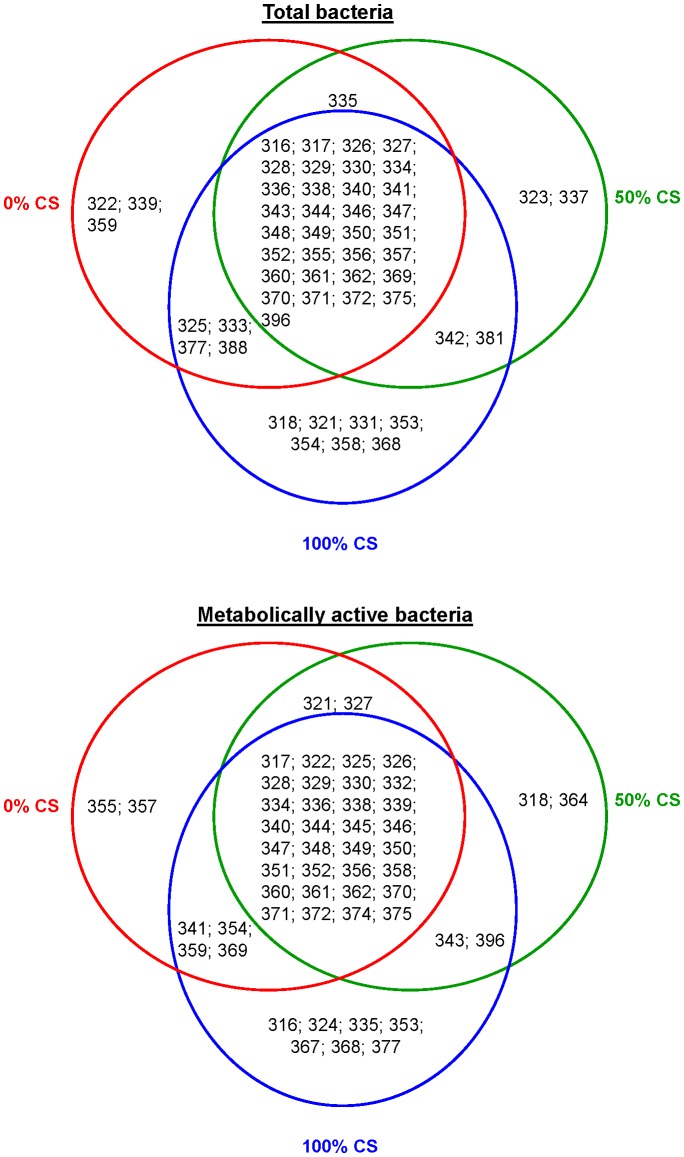
Venn Diagrams of bacterial LH-rrs amplicons representing shared and diet-specific amplicons that compose the total and the metabolically active bacterial communities.Total ruminal content (n = 9 cows for each diet) was collected before the a.m. feeding from dairy cows fed 0, 50 or 100% corn silage (CS).